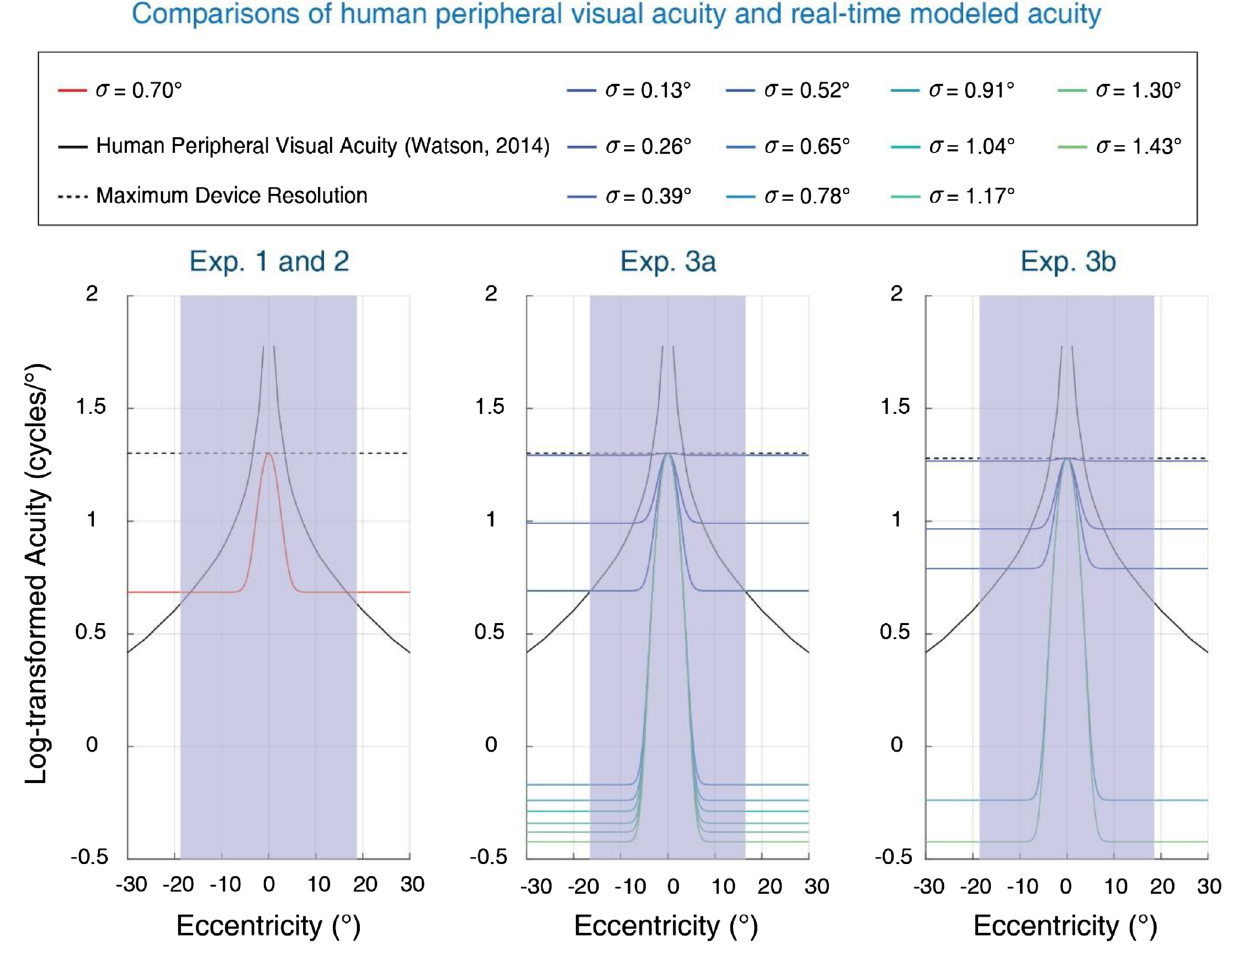
Figure 7. Comparisons of human peripheral visual acuity and the visual acuity simulated by digit-tracking in three experiments. Experiments 1 and 2 used the same blur level as Lio et al. 4 . Experiment 3a tested 30 blur levels but only the first 11 levels were shown here. Experiment 3b used 5 blur levels selected from Experiment 3a. Purple areas represent the screen